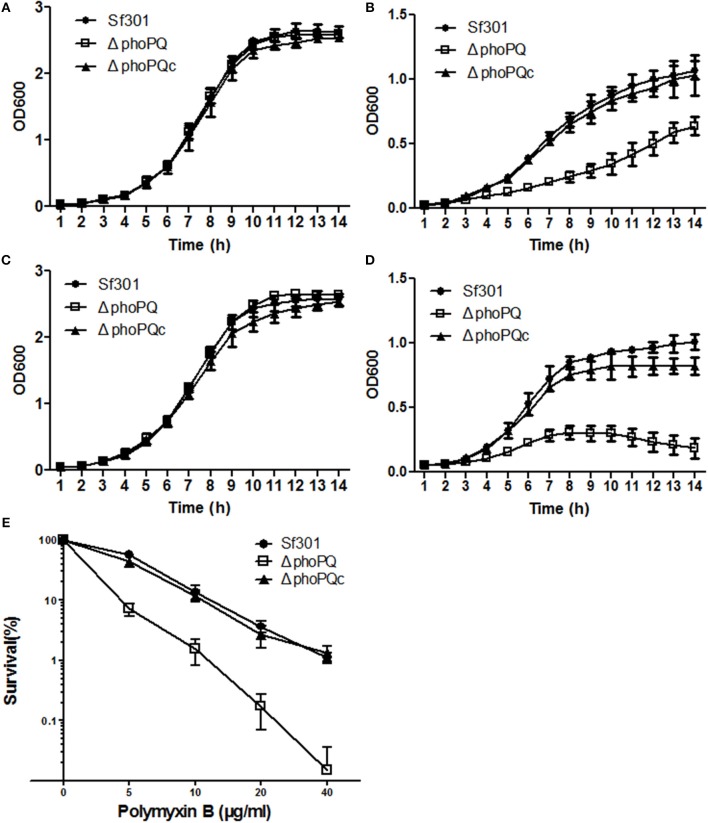
PhoPQ is required for Shigella to resist an environment of low Mg2+, acidic pH, or the presence of polymyxin B. Sf301, ΔphoPQ and ΔphoPQc were grown in N minimal medium supplemented with 10 mM MgCl2
(A) or 10 μM MgCl2
(B). The OD600 was determined every 60 min for 14 h. Sf301, ΔphoPQ and ΔphoPQc were grown in E glucose broth at pH 7 (C) or pH 5 (D). The OD600 was determined every 60 min for 14 h. Sf301, ΔphoPQ and ΔphoPQc were diluted in sterile 0.85% saline to about 5 × 103 cells per ml, and exposed for 1 h at 37°C to various concentrations of polymyxin B. Survivors were measured by plating on LB. The survival rate was calculated as the number of bacteria treated with polymyxin B divided by that of the untreated control (E). Results are mean from three independent assays performed in duplicate. Error bars correspond to standard deviations.